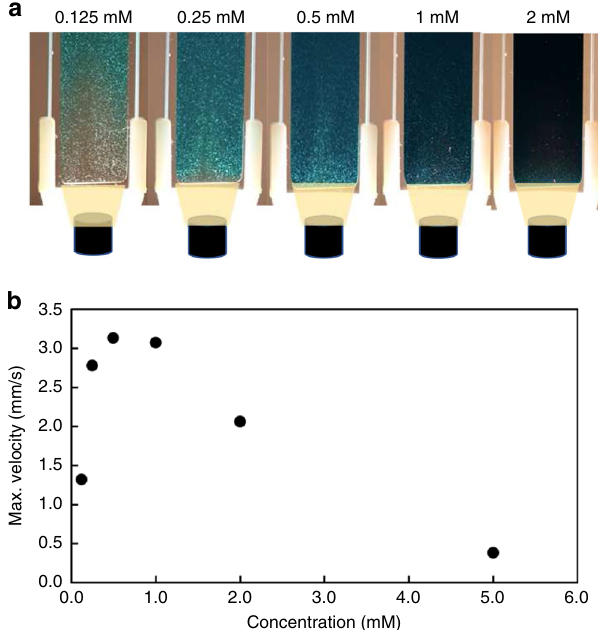
Fig. 4 Non-linear concentration dependence of particle velocity. a Concentrations ranging from 0.125 to 2 mM of DASA in toluene shown from left to right after 10 s of irradiation with 46 mW cm − 2 light. b Particle velocities as a function of concentration show the nonlinear dependency on concentration. Above 0.5 mM, the dark solution exhibits a masking effect that limits light penetration and, as a result, limits particle